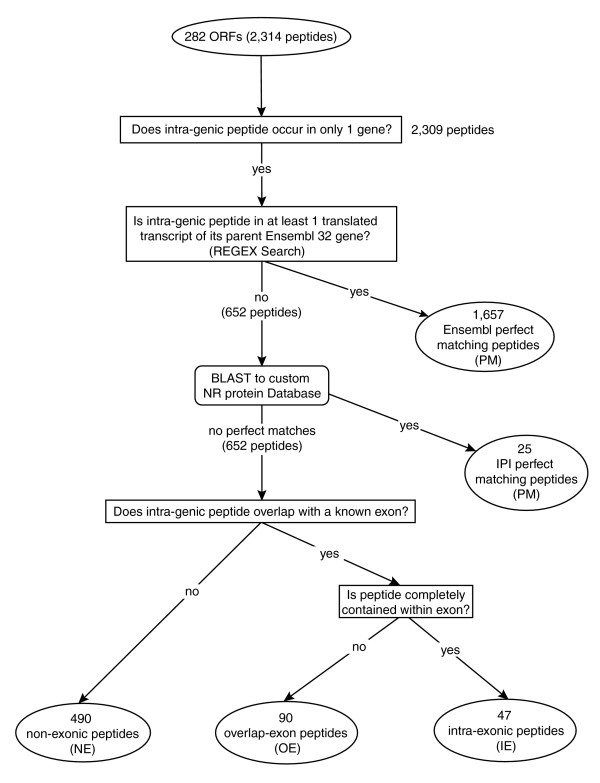
Selection and classification of diagnostic peptides. The flowchart outlines how diagnostic peptides found in high-confidence ORFs were classified into four categories: perfect match (PM), intra-exonic (IE), overlapping exon (OE), and non-exonic (NE).